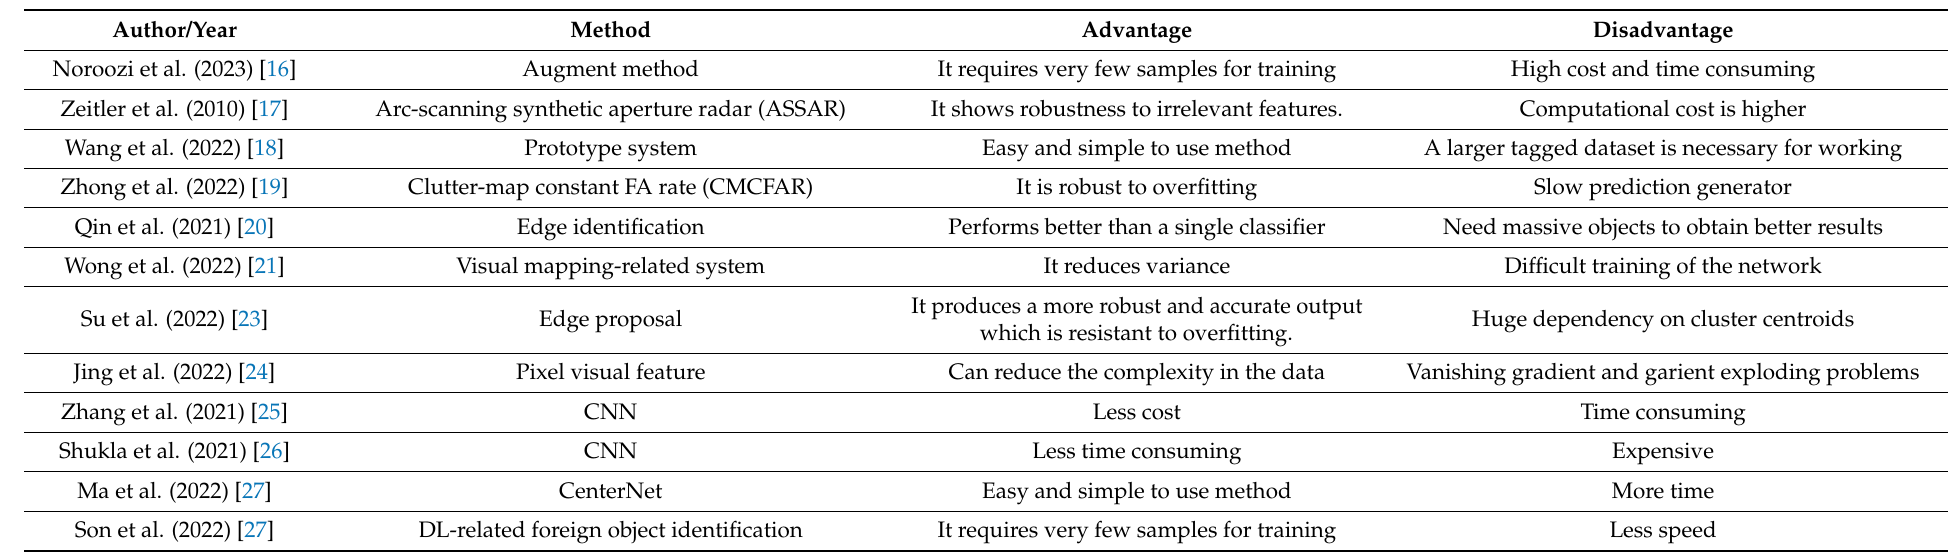
Table 1. Comparison between existing and proposed